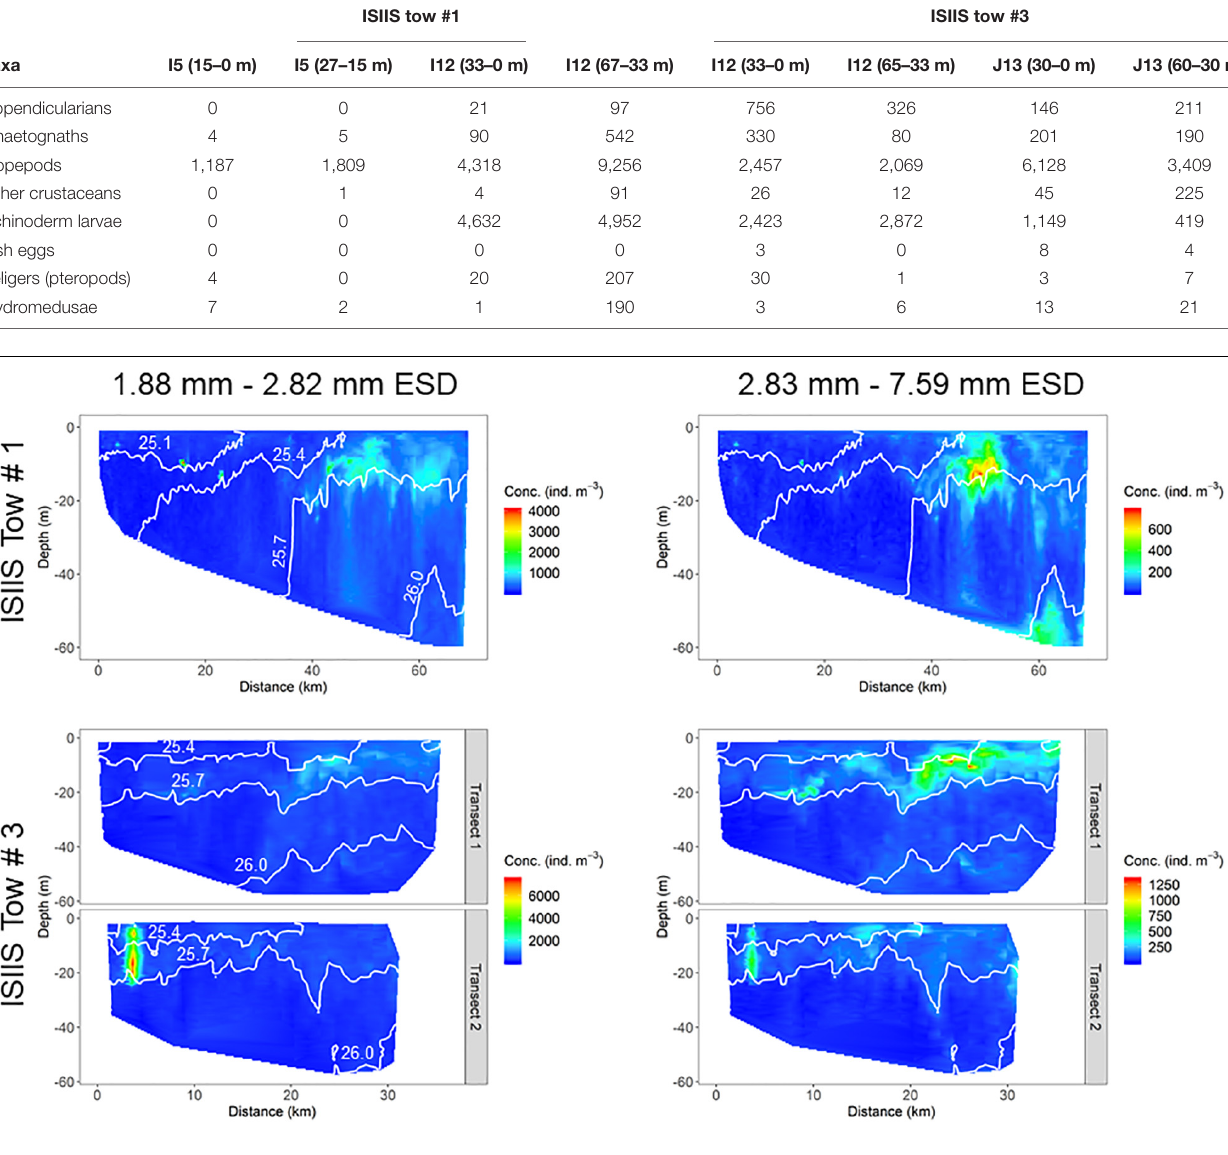
FIGURE 9 | Distribution of particles for two size classes from the ISIIS for both